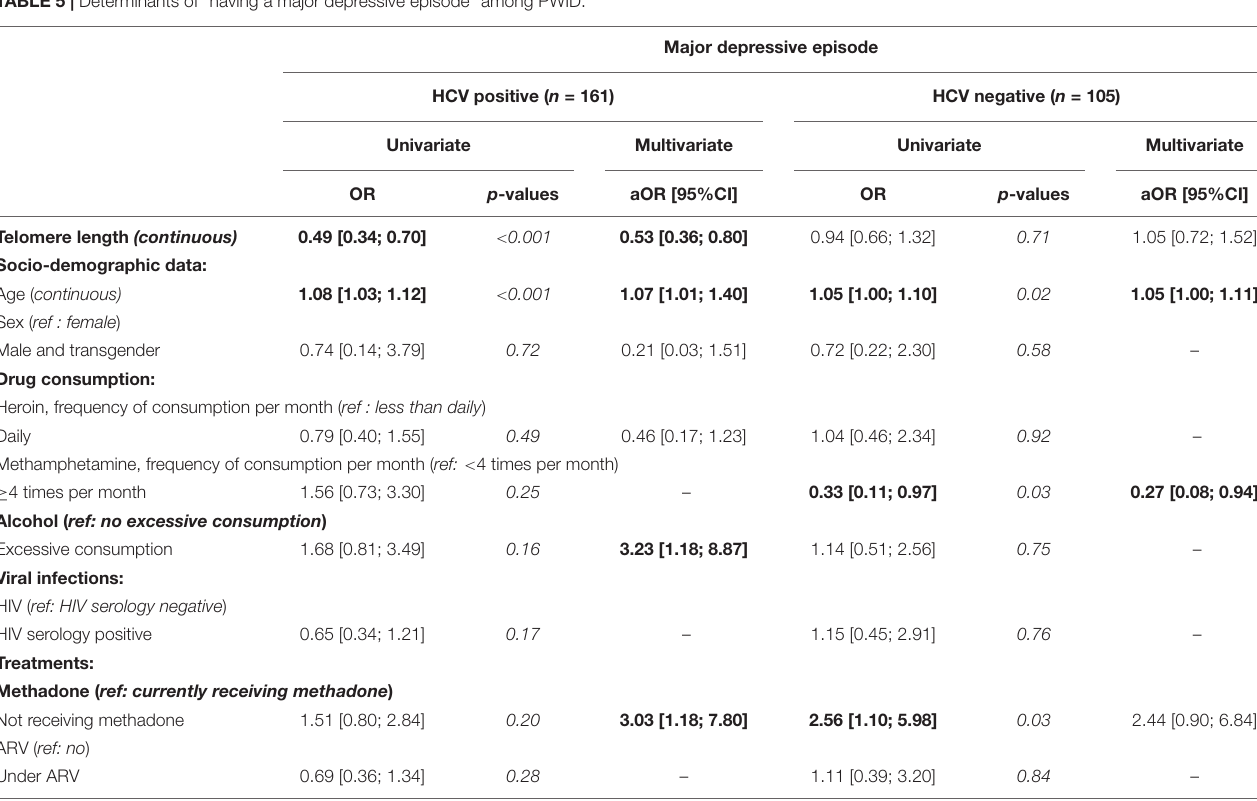
TABLE 5 | Determinants of “having a major depressive episode” among